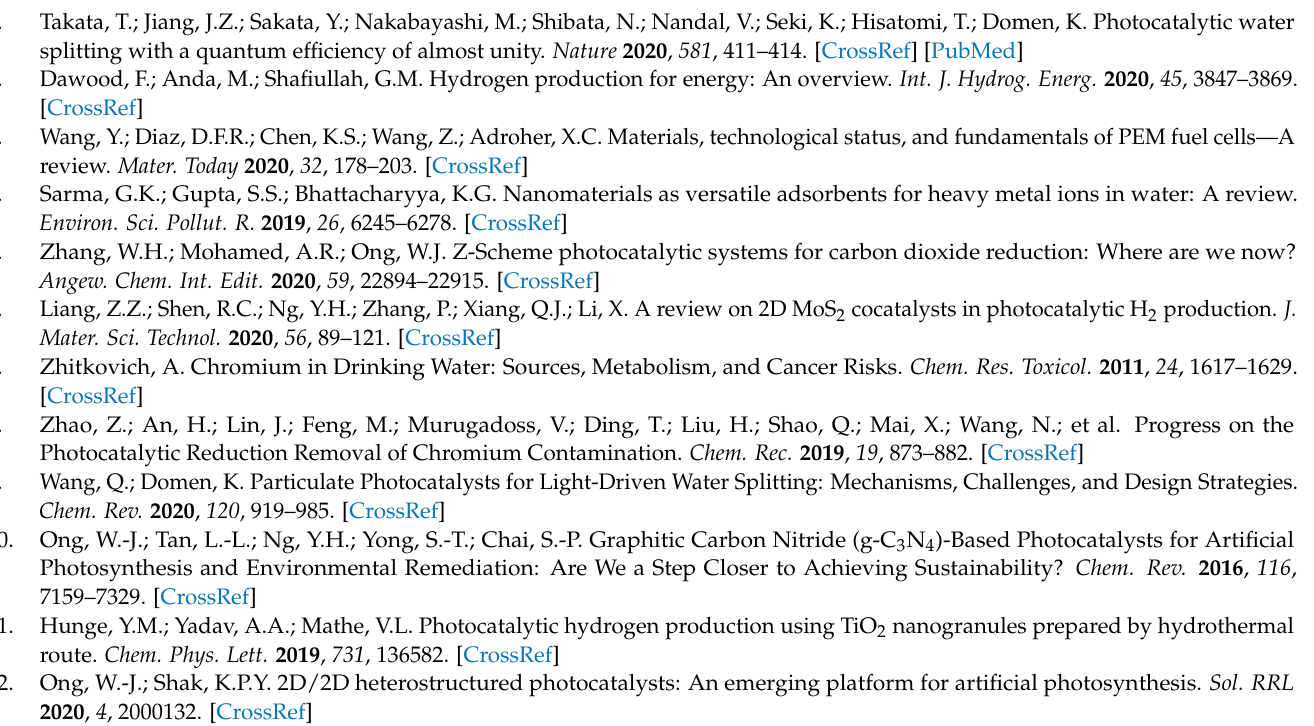
Co. Ltd., Figure S2: XRD patterns of (a) NC-120, NC-150, NC-180, NC-190, (b) CIS-4, CIS-4.4, CIS-6 and CIS-8, (c) HP-180, HP-180-1 and HP-180-2, and (d) HP-180, HP-180-3 and HP-180-4, Figure S3: (a) TEM and (b) HRTEM images of HP-180 recorded from a different area, other than that used in Figure 3c,d, Figure S4: XPS survey spectra of CIS-4, NC-180 and HP-180, revealing that the heterostructure catalyst is mainly com-posed of Cd, Cr, In, Ni, C, O and S elements, Figure S5: The band structure (a,b) and partial density of states (PDOS) (c,d) of CIS-4 and NC-180, respectively, Figure S6: Photocatalytic H2 production when 10, 50 and 100 mg HP-180 were used. It can be observed that the photocatalytic activity is related to the amount of catalyst and 50 mg leads to higher H 2 yield, Figure S7: (a) Photocatalytic H 2 production and (b) evolution rate over HP-180, HP-180-1 and HP-180-2. (c) Photocatalytic H 2 production and (d) evolution rate over HP-180, HP-180-3 and HP-180-4, Figure S8: Photocatalytic reduction efficiencies Cr(VI) over HP-180 in the presence of electron scavenger (AgNO 3 , 1 mM), Figure S9: Photographs of powder samples and preparation of film samples for EIS and photocurrent response measure-ments. From left to right 1 (cid:13) HP-190, 2 (cid:13) HP-180, 3 (cid:13) HP-150, 4 (cid:13) HP-120, 5 (cid:13) CIS-4, 6 (cid:13)